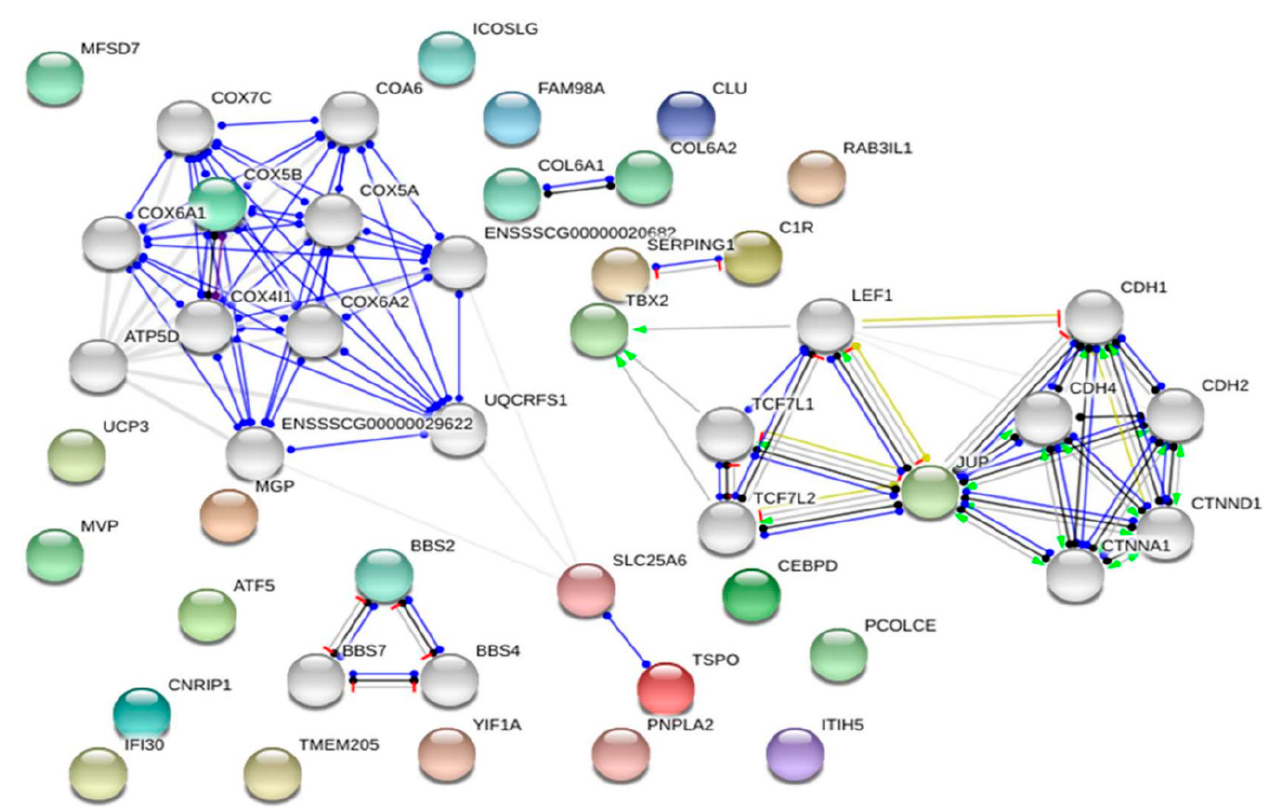
Figure 5. Upregulation of differentially expressed genes in the muscle of pigs with greater-than-normal muscle mass. Identified genes were colored and marked in grey; line shape represents anticipated mode of action. Lines colored represent anticipated mode of action (red shows interactions that were experimentally identified; blue shows interactions from selected databases; black shows coexpression; green shows text-mining relations and interactions contingent on appropriate researches stating a transfer from different organisms; and yellow shows transcriptional adjustment [164].